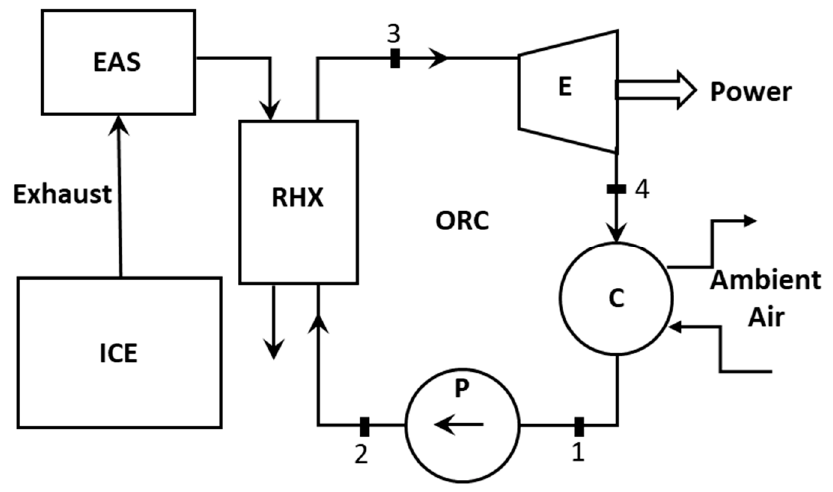
Figure 1. Sketch of the ORC system.